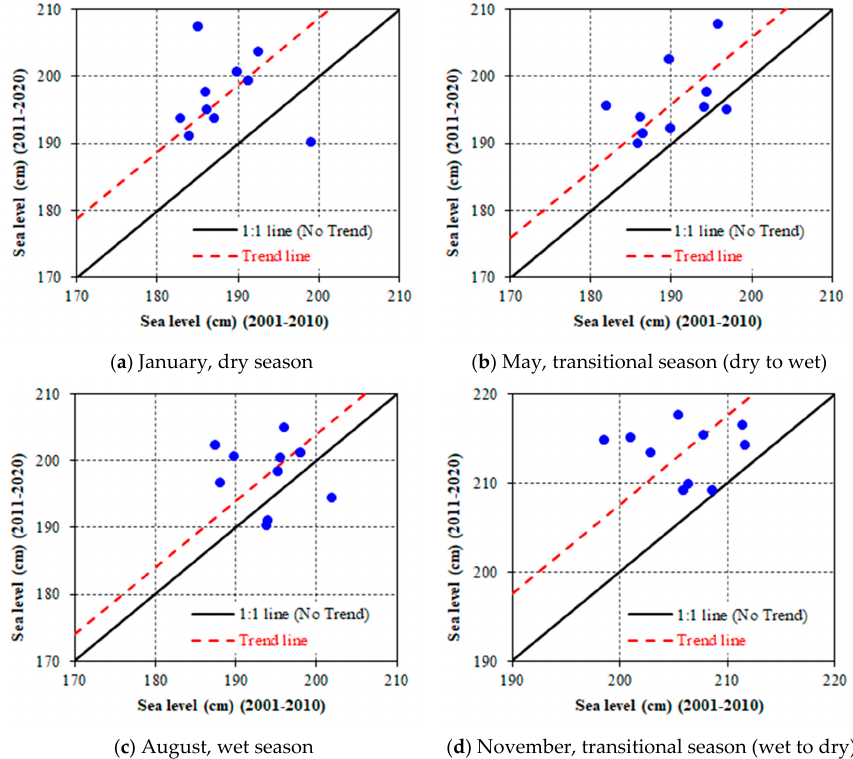
Figure 8. Results of the ITA on monthly sea level in different seasons for the Hon Dau station (2001–2020.